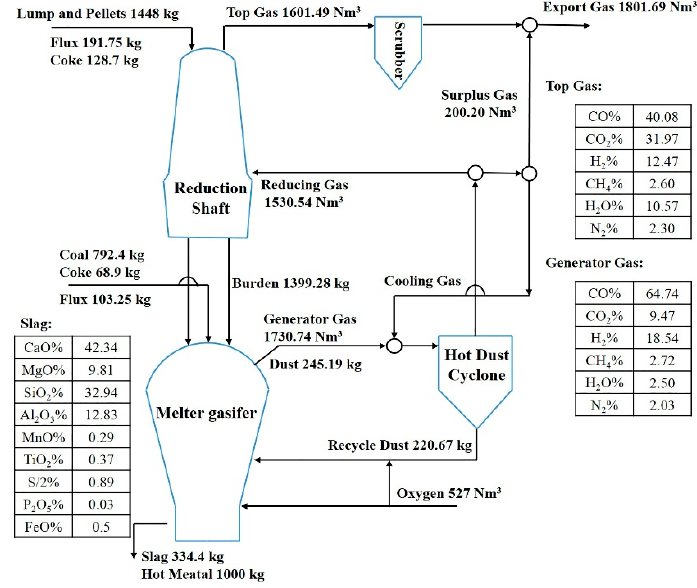
Figure 2. Specific mass flow in the COREX process.